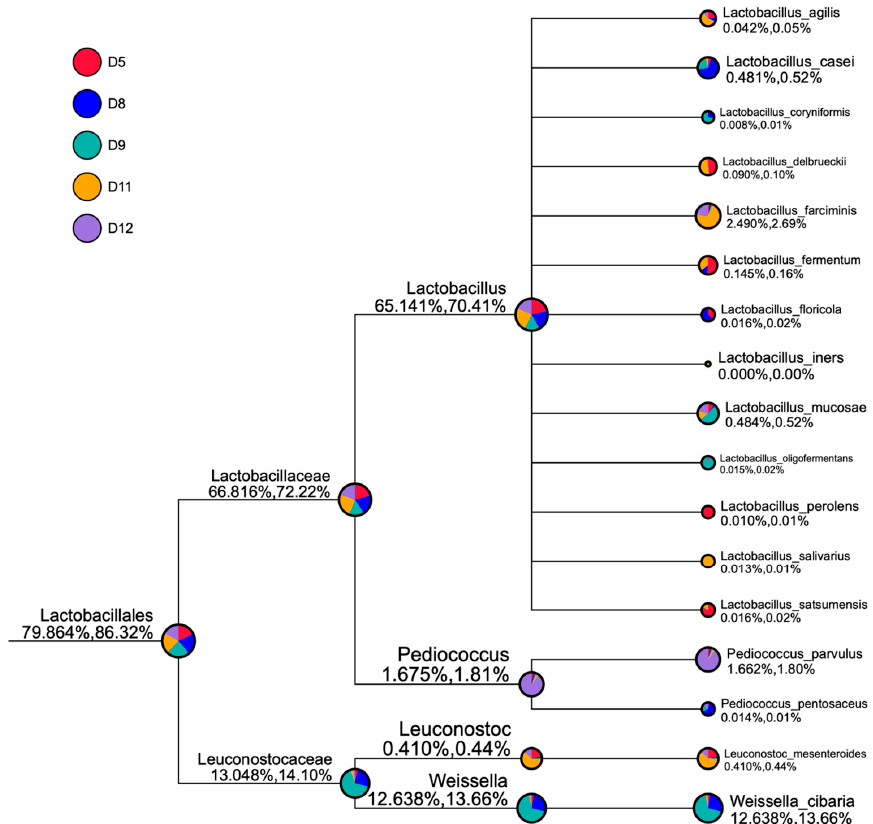
Figure 3. Taxonomy tree profile of the lactic acid bacteria in the studied sourdough samples. The size of the circles represents the relative abundance of species. The first number below the taxonomic name represents the percentage in the whole taxon, while the second number represents the percentage in the selected taxon. Different colors represent different samples. New classification in Lactobacillus taxonomy is as follows : Ligilactobacillus agilis (Lactobacillus agilis) , Lacticaseibacillus casei (Lactobacillus casei) , Loigolactobacillus coryniformis (Lactobacillus coryniformis) , Companilactobacillus farciminis (Lactobacillus farciminis) , Limosilactobacillus fermentum (Lactobacillus fermentum) , Holzapfelia floricola (Lactobacillus floricola) , Limosilactobacillus mucosae (Lactobacillus mucosae) , Paucilactobacillus oligofermentans (Lactobacillus oligofermentans) , Schleiferilactobacillus perolens (Lactobacillus perolens) , Ligilactobacillus salivarius (Lactobacillus salivarius) , Liquorilactobacillus satsumensis (Lactobacillus satsumensis).